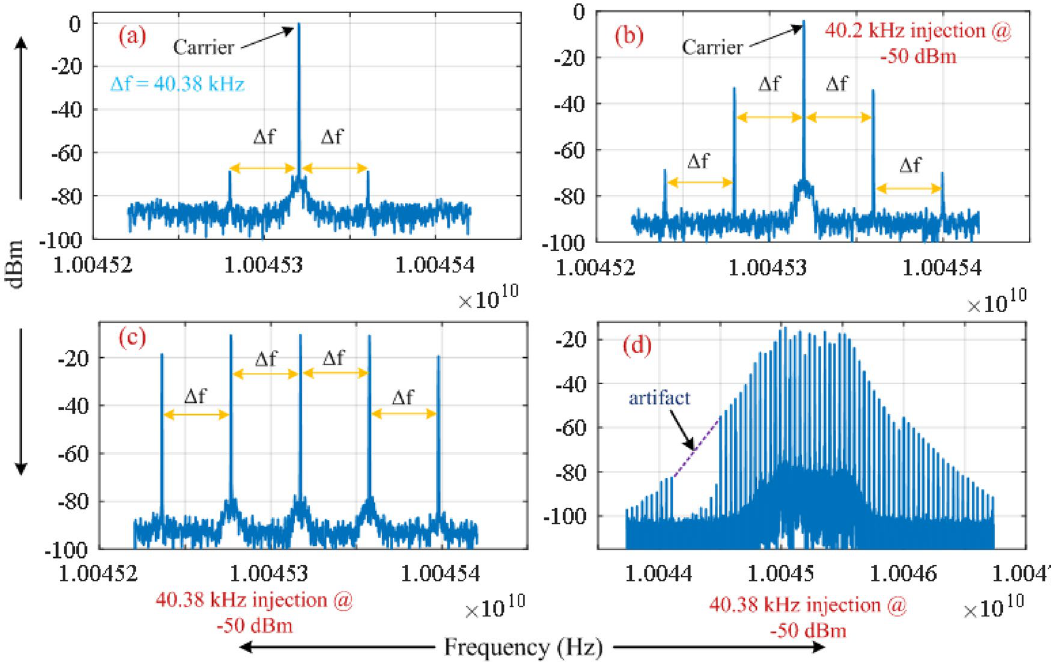
Figure 4. Measured electrical spectrum for ( a ) the free OEO and ( b – d ) with small (− 50 dBm) injection of sinusoidal intra-loop phase modulation via the phase shifter having frequencies close to the inter mode frequency interval. A resolution bandwidth of 100 Hz is used for all the measurements. A span of 200 kHz is used for ( a – c ); whereas a span of 3 MHz is used for ( d ). The artifact in ( d ) is a text file error when saving a spectrum with a large number of